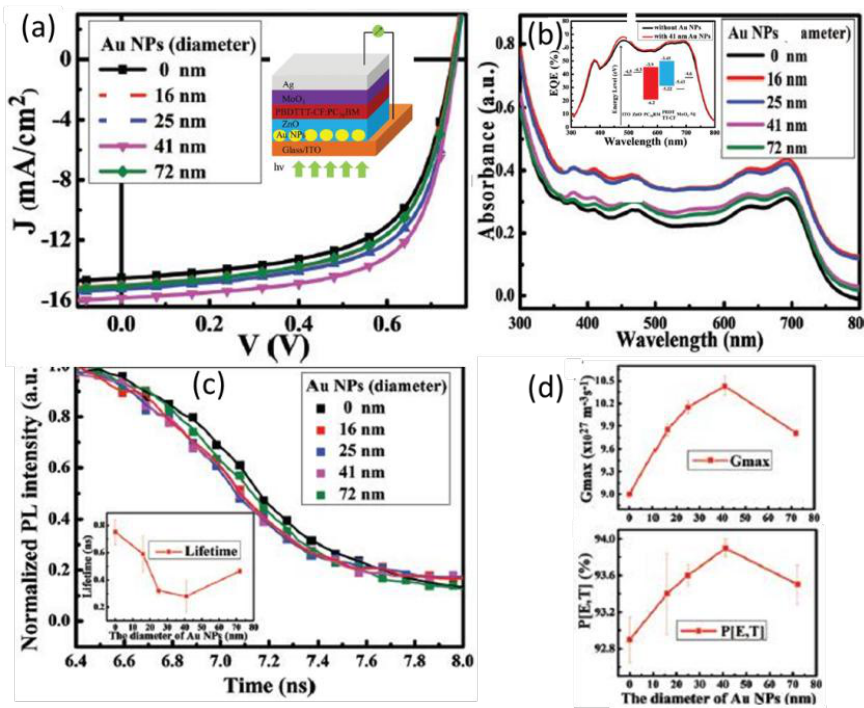
Figure 19. ( a ) J-V curves of the devices with various Au particle sizes. The inset is the schematic of the device structure. ( b ) Absorbance spectra of the structure of ITO/Au NPs:ZnO/PBDTTT-CF:PC70BM with various Au particle sizes. The inset is EQE spectra of the device without Au NPs and the device with 41 nm Au NPs. ( c ) Transient PL decays of the structures of ITO/Au NPs:ZnO/PBDTTT-CF:PC 71 BM with different sizes of Au NPs. The inset gives the dependence of the lifetime on the diameters of Au NPs. ( d ) The dependence of the maximum exciton generation rate Gmax and exciton dissociation probability P(E, T) on the diameters of Au NPs [73]. Reprinted with permission from Ref. [73].